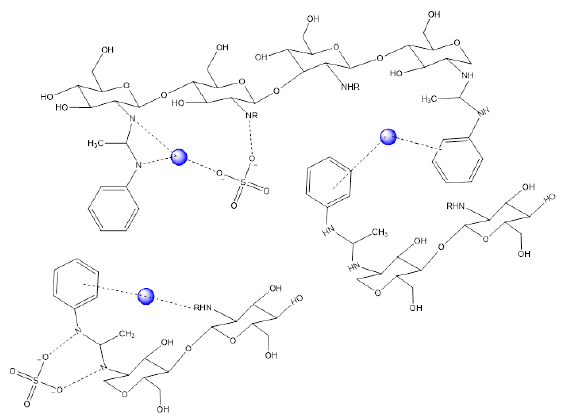
Figure 5. CS-Ac-An structure with interactions (dotted lines) between Cu(II) (blue circles) ions and active sites of the adsorbent, where the solvent is omitted for clarity purposes.